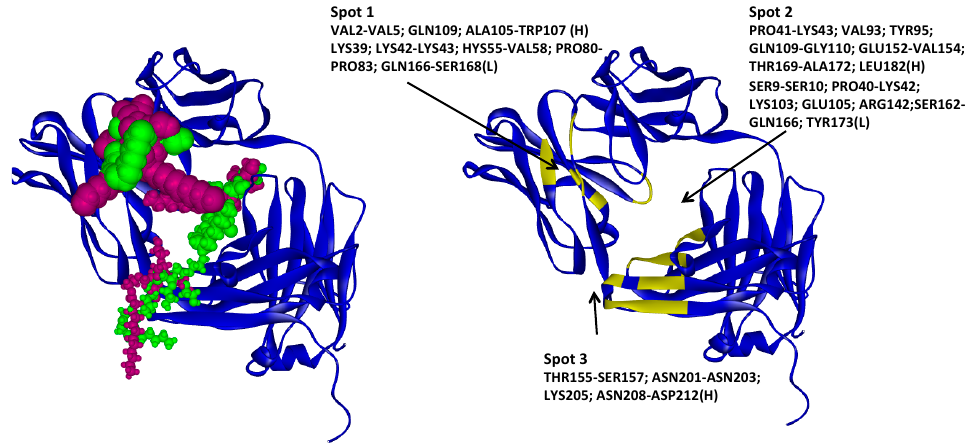
Figure 8. Molecular Docking results for polysorbate 20 and 80 obtained with GLUE software. A33 is displayed in blue ribbons, polysorbates are represented in green and purple ( left ); The higher affinity molecules are displayed as CPK and lowest as tube or ball and stick. A33 residues involved in each identified spot ( right ).